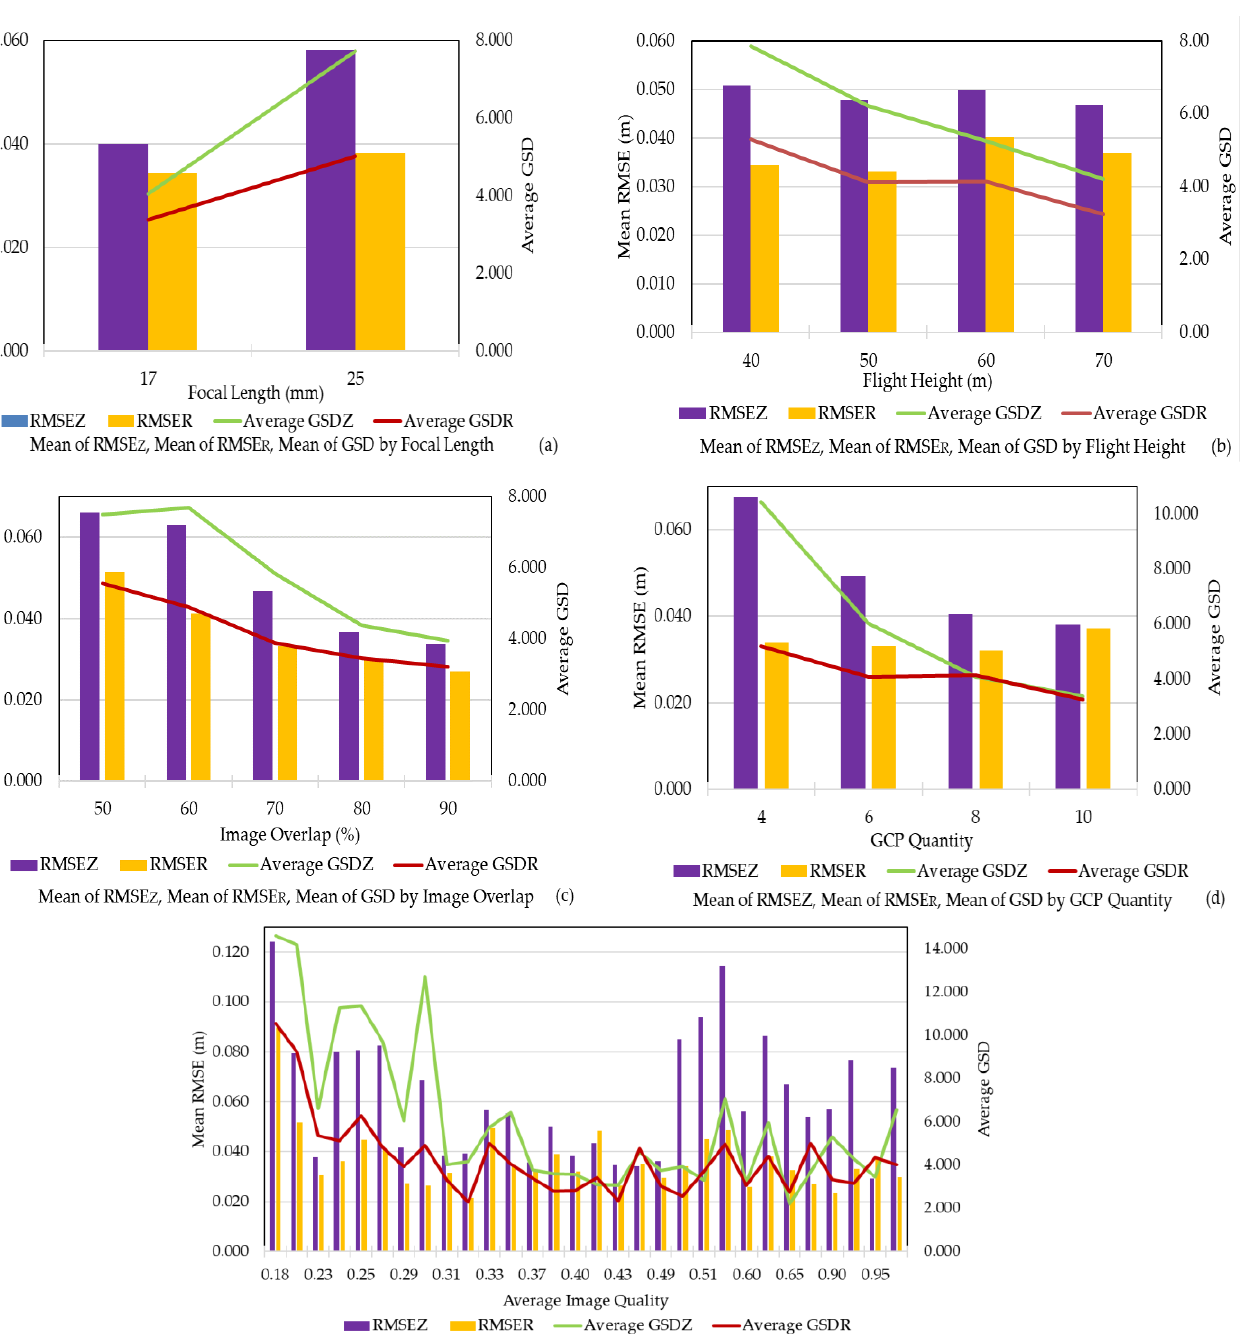
Figure 9. Mean of RMSE Z , RMSE R , and average GSD for Five Influence Factors: ( a ) Focal Length; ( b ) Flight Heights; ( c ) Image Overlaps; ( d ) GCP Quantities; and ( e ) Average Image Quality.